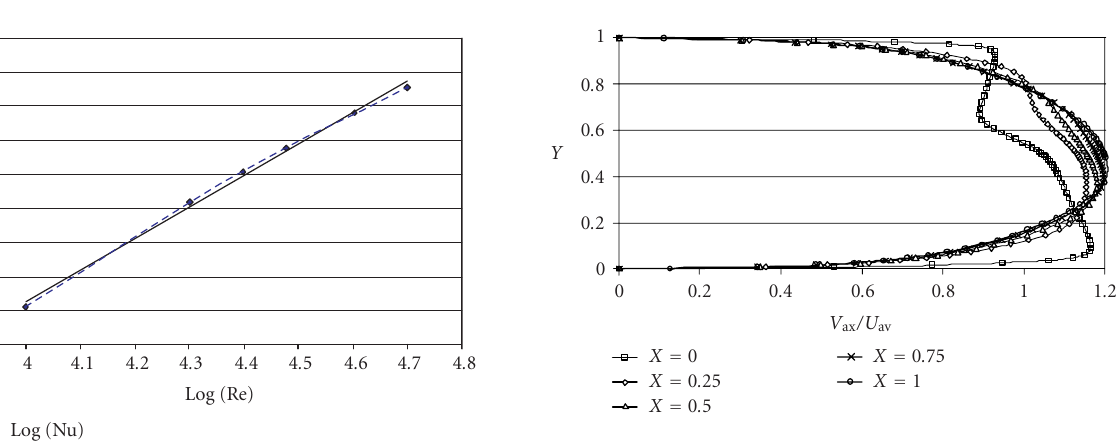
Figure 11: Axial velocity profiles at di ff erent sections of the cooling channel for Re = 10000 and ˙ m r = 1 / 2.